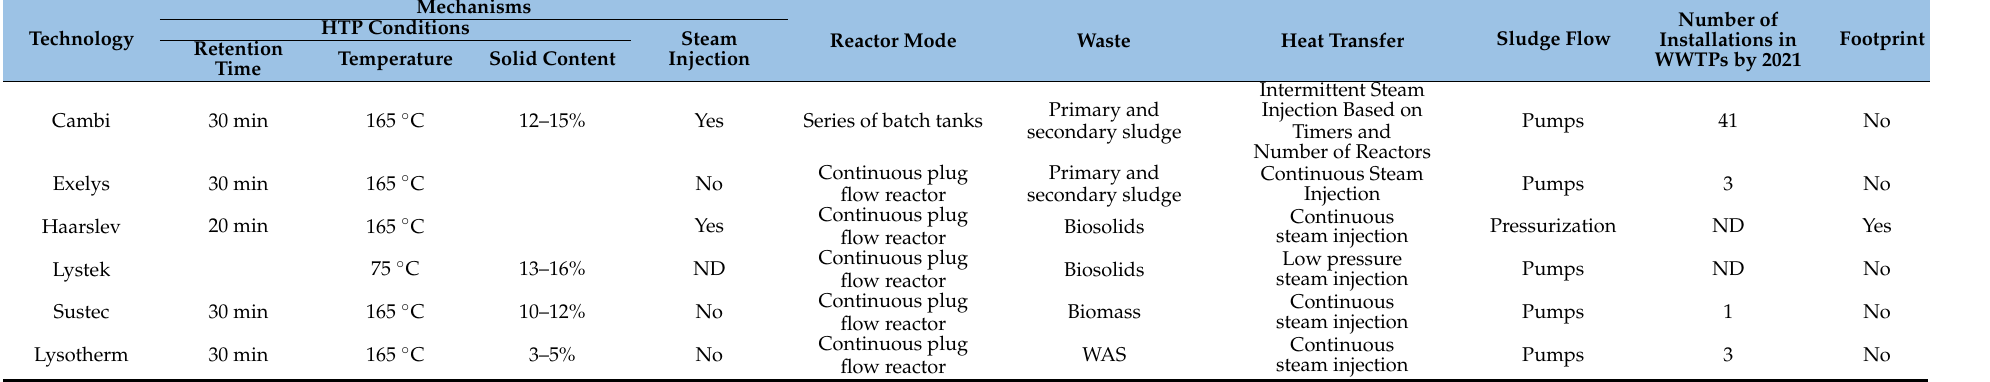
Table 4. Comparison of commercially available full-scale hydrothermal pretreatment/post-treatment